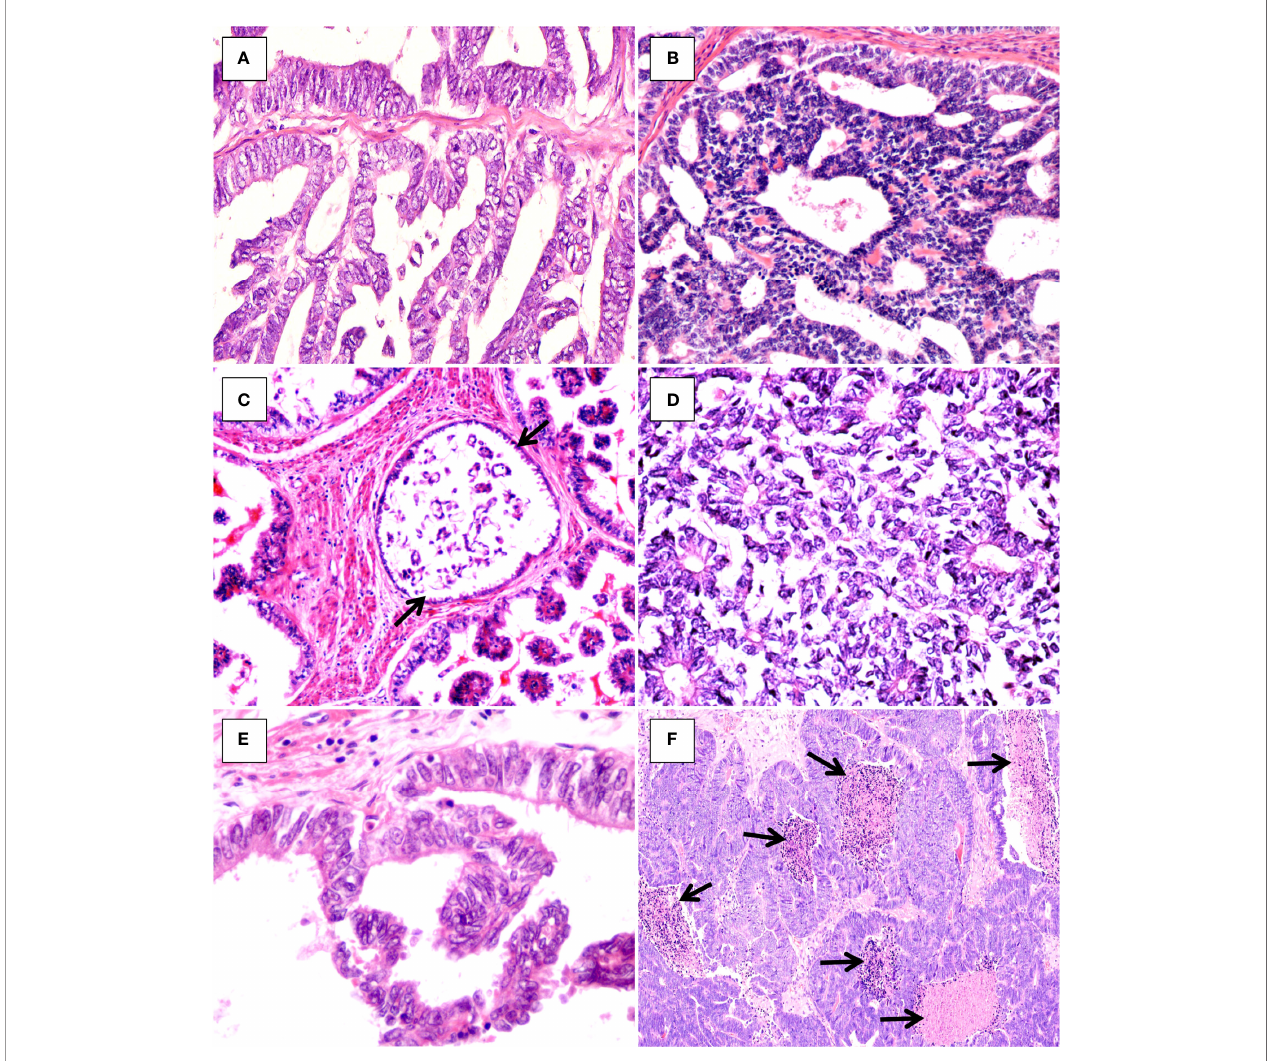
FIGURE 4 | Histopathologic fi ndings of uterine corpus MLA. (A) Columnar tumor cells (case1, HE×400). (B) Cuboidal tumor cells (case 4, HE×400). (C) Hobnail tumor cells (arrows, case 2, HE×300). (D, E) Vesicular, overlapping nuclei with nuclear grooves (D) , case 3, HE×300; (E) , case 2, HE×400). (F) Intraluminal comedo- like necrosis (arrows, case 4, HE×100).